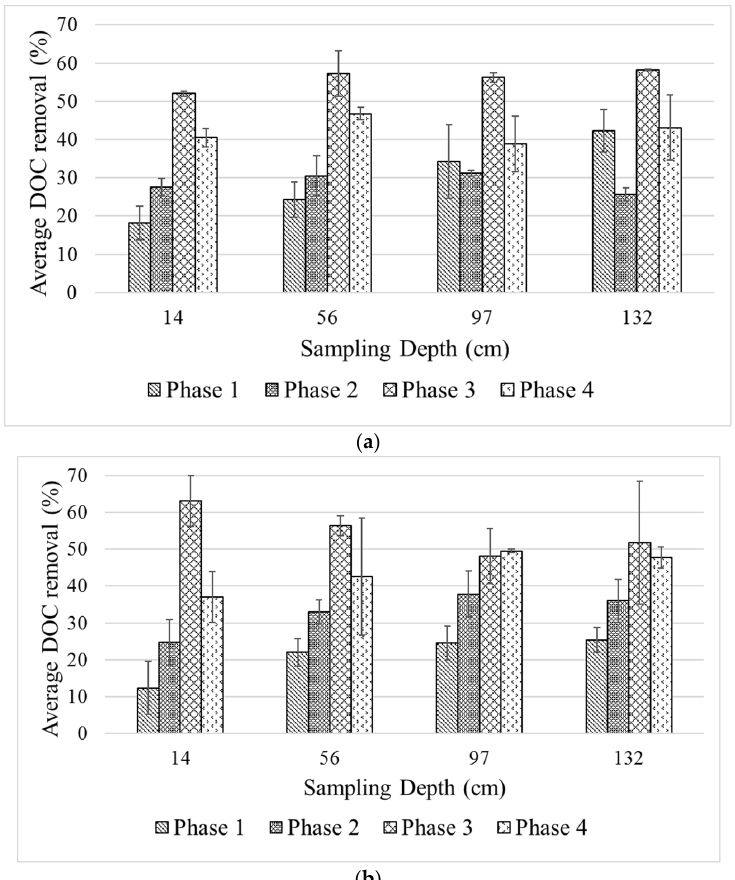
Figure 4. Level of DOC at different sampling points (i.e., filter depths) in ( a ) Column 1 and ( b ) Column 2 at different phases of experiment.